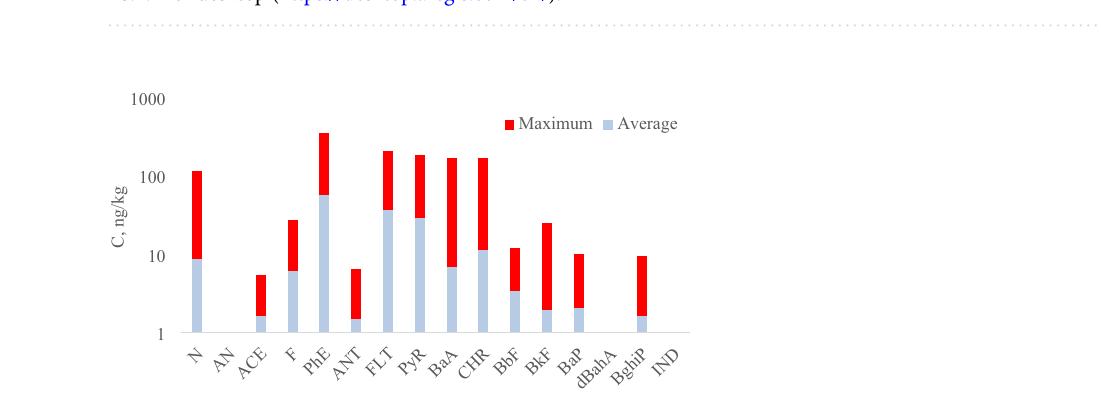
Figure 3. The distribution of priority PAHs for individual